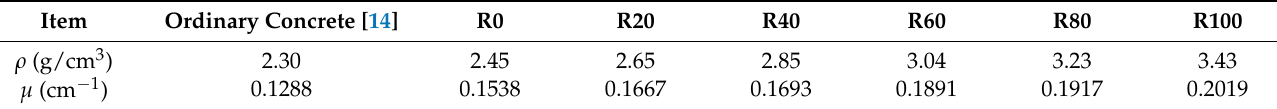
Table 4. Linear attenuation coefficients of MUHPC.